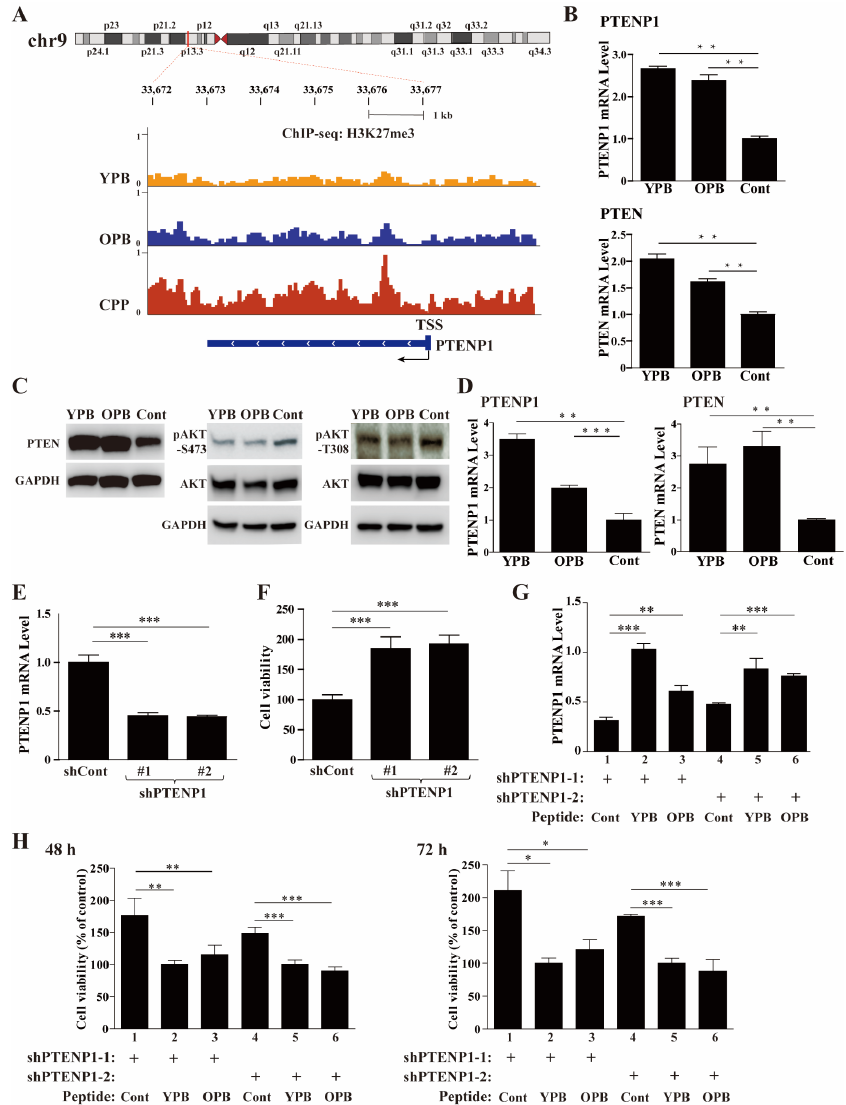
Figure 7. PTENP1 is one of the primary targets of YPB and OPB peptides in breast cancer cells. ( A ) Gene browser tracks of the H3K27me3 ChIP-seq at the PTENP1 locus on chromosome 9 (chr9) in the genomic DNA of MDA-MB-231 cells treated by the peptides. The yellow, blue, and red peaks represent the degrees of H3K27me3 enrichment after the treatments for 48 h by 30 µ M of the YPB, OPB, and Cont peptides, respectively. The region of the PTENP1 gene is labeled at the bottom panel. TSS: transcription start site. ( B , C ) Alterations of genes in the AKT pathway in response to the peptide treatments. After the treatment of MDA-MB-231 cells by the YPB, OPB, and Cont peptides, the cell lysates were analyzed by RT-qPCR to evaluate PTENP1 and PTEN transcript levels ( B ), and by Western blot analysis to determine the levels of PTEN, pAKT-S473, p-AKT-S308, and AKT, with GAPDH as a control ( C ). ( D ) Examination of PTENP1 and PTEN expression in xenograft tumors by qPCR. ( E , F ) Effects of shPTENP1-1 and -2 on the expression of the endogenous PTENP1 transcript ( E ) and viability ( F ) of MDA-MB-231 cells. ( G , H ) Effects of the cotreatments by shPTENP1-1/2 and each of the peptides on the PTENP1 transcript levels ( G ) and the viability ( H ) of MDA-MB-231 cells. The cells were infected by lentiviruses carrying either of the shPTENP1-1/2, and then treated for 48 h by 30 µ M of the YPB, OPB, and Cont peptides. Relative PTENP1 transcript levels were determined by RT-qPCR, while the cell viability was calculated based on WST-1 assays. All data were normalized against the data of YPB. Each experiment was repeated at least 3 times with representative data presented. Data are shown as the mean ± S.D. * p < 0.05, ** p < 0.01, *** p <